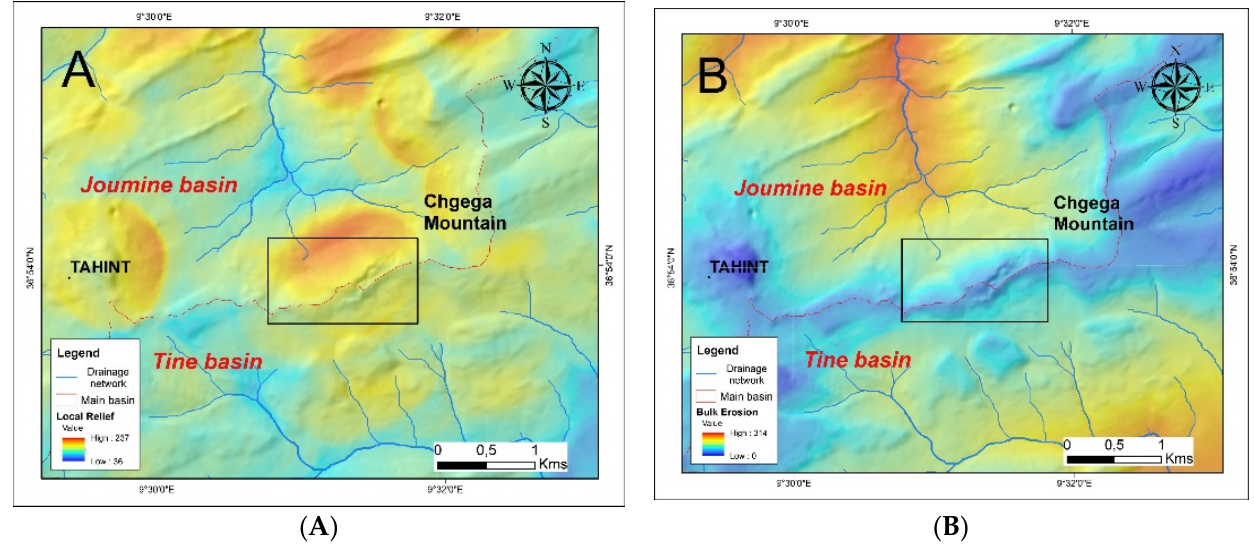
Figure 11. ( A ) Map of the local relief of the Chgega surroundings. Local relief was calculated estimating the elevation range at 500 m of each point of the terrain. Note that Chgega shows the highest values in the ridge that define the limit between the Joumine and Tine River basins. ( B ) Map of the bulk erosion volume (proxy for maximum potential erosion) of the Chgega surroundings. Chgega